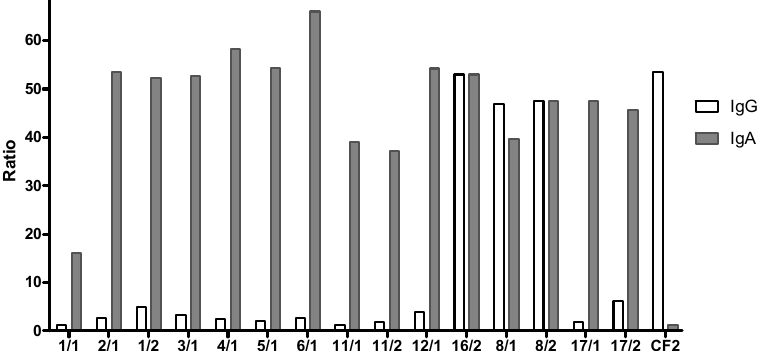
Figure 2. Detection of badger IgA and IgG by mAbs. Ratio value (OD value divided by the corresponding baseline value) for each mAb, showing recognition of sIgA from bile and additionally, of serum IgG by mAbs 16/2, 8/1 and 8/2. CF2 = mAb specific for badger IgG [12].